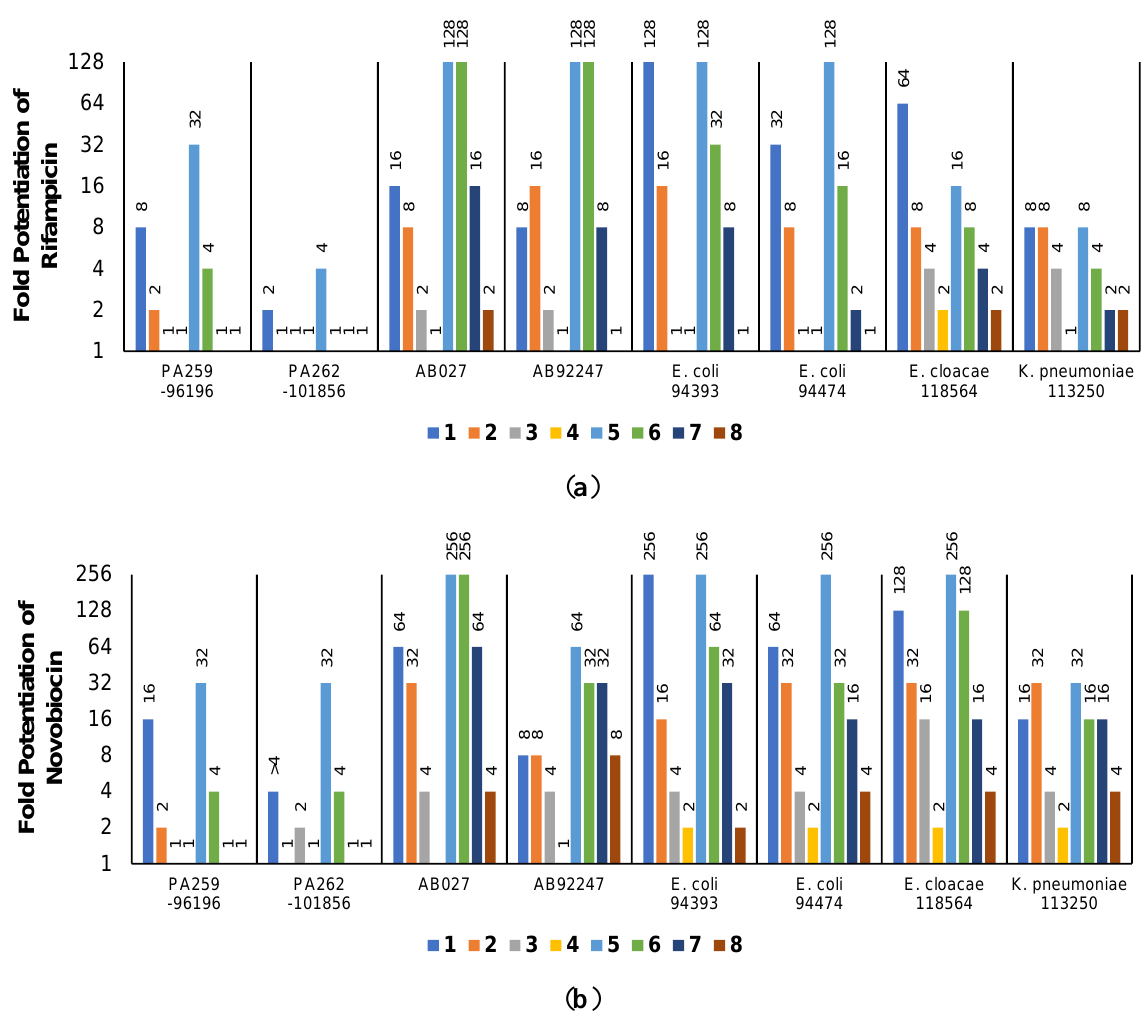
Figure 2. Potentiation of ( a ) RIF, ( b ) NOV, ( c ) NIC, and ( d ) CHL by 6 μ M UTBLP against wild-type GNB.